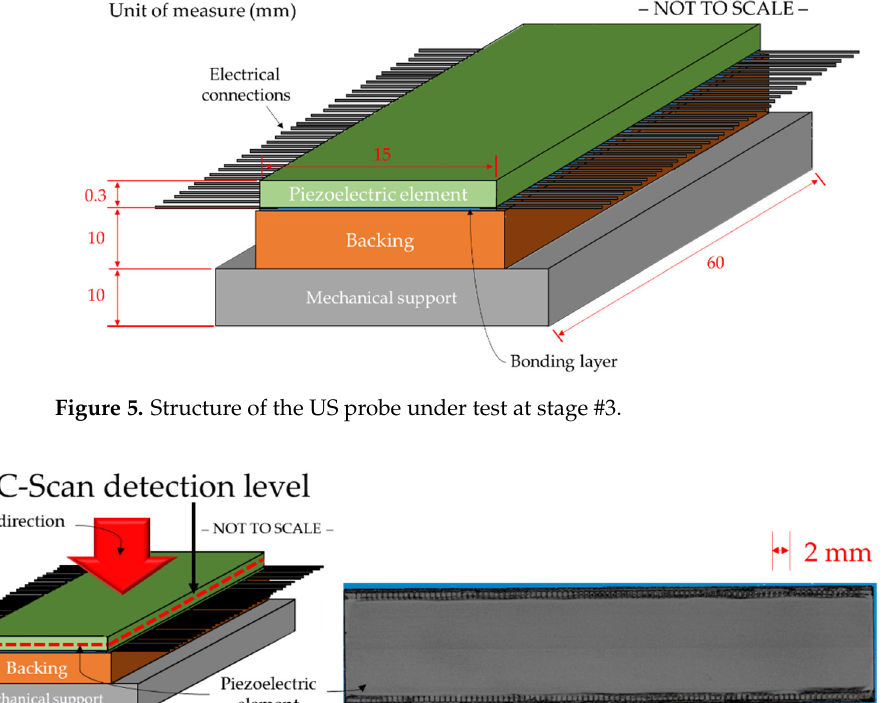
Figure 7. Latent defect detected in the workpieces at stage #3: crack in the US probe bulk (red rectangular). The detection is provided by SAM. 5. Discussion The collaboration between statisticians and engineers led to implementing the gen- eral PDCA cycle (Figure 8). The identification of main failures and the weak points of the manufacturing process, the implementation of regression models and the detection of la- tent failure at the early stage of the process allowed for optimizing the overall production cycle. Figure 8. Plan-do-check-act (PDCA) cycle for the continuous improvement in US probes manufacturing process.